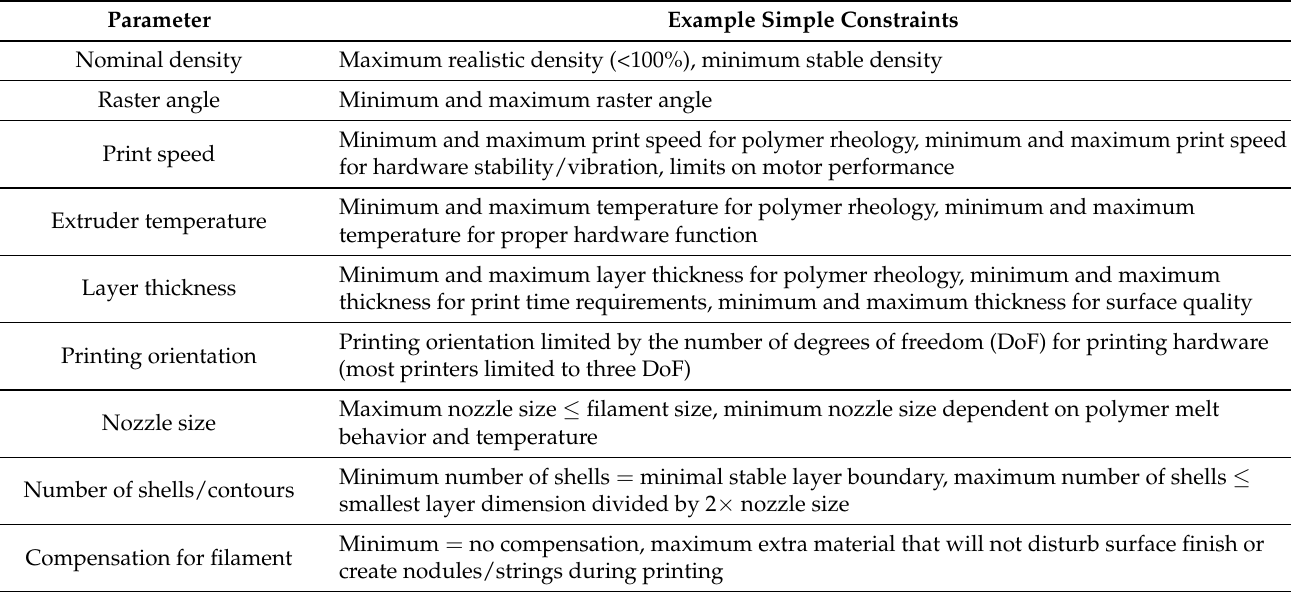
Table 2. Example constraints for the general parameters found during the survey presented in Table